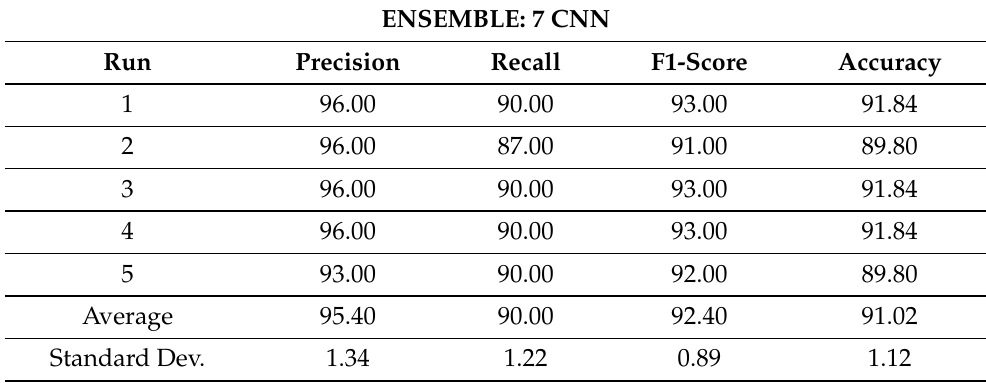
Table 8. Summary of the results obtained with the CNN-ensemble model. We collect the obtained test set metrics computed over five different runs. The last two rows report the average over the runs and the corresponding standard